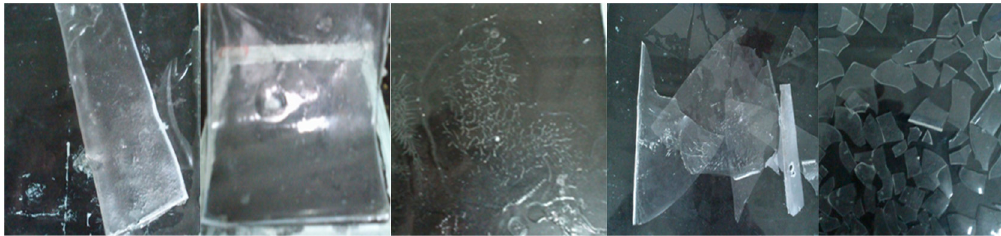
Figure 11. Film-forming properties of different monomer ratios. (Visual inspection after film formation curing.).